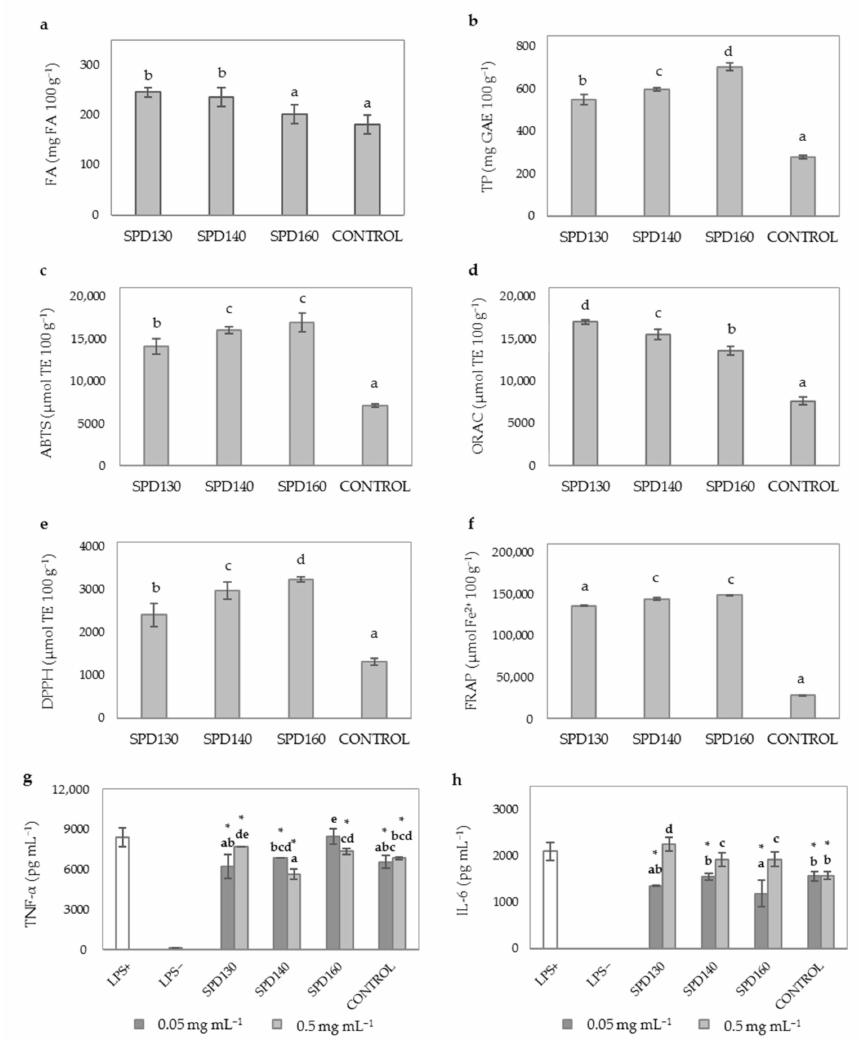
Figure 5. Evaluation of the SPD inlet temperature on phenolic compounds content, TAC and AIA of WB hydrolysates. ( a ) FA content (mg 100 g − 1 ); ( b ) TP content (mg GAE 100 g − 1 ); ( c ) ABTS scavenging activity ( µ mol TE 100 g − 1 ); ( d ) ORAC ( µ mol TE 100 g -1 ); ( e ) DPPH scav- enging activity ( µ mol TE 100 g -1 ); ( f ) FRAP ( µ mol Fe 2+ 100 g -1 ); ( g ) TNF- α levels (pg mL − 1 ); ( h ) IL-6 levels (pg mL − 1 ). Sample identification: hydrolyzed WB treated at HT15 (CONTROL), hydrolyzed WB spray-dried at 130 ◦ C (SPD130), 140 ◦ C (SPD140), or 160 ◦ C (SPD160). Different lowercase letters show significant differences between samples (one-way ANOVA, post hoc Duncan’s test, p ≤ 0.05). * indicates significant differences for mean values relative to treated cells (LPS+) (one-way ANOVA, post hoc Duncan’s test, p ≤ 0.05). Abbreviations: Abbreviations: 2,2 (cid:48) -azino-bis (3-ethylbenzothiazoline-6-sulfonic acid) (ABTS); 2,2-diphenyl-1-picryl-hydrazyl-hydrate (DPPH); fer- ulic acid (FA); ferric reducing antioxidant power (FRAP); gallic acid equivalents (GAE); interleukin-6 (IL-6); lipopolysaccharide (LPS); oxygen radical absorbance capacity (ORAC); Trolox equivalents (TE); total phenolics (TP); tumor necrosis factor-alpha (TNF- α ). Water activity (a w ) of dried WB hydrolysates in all tested conditions was under 0.32 and SPD130 showed the lowest values (Table 4) although the differences were not significant between treatments. This could be explained by the loss of water binding structures with increasing temperatures, while water content remaining similar, resulting in an inversely proportional relation between aw and inlet air temperature. Water molecules trapped inside macromolecules or immobilized by hydrogen binding require more energy to be evaporated